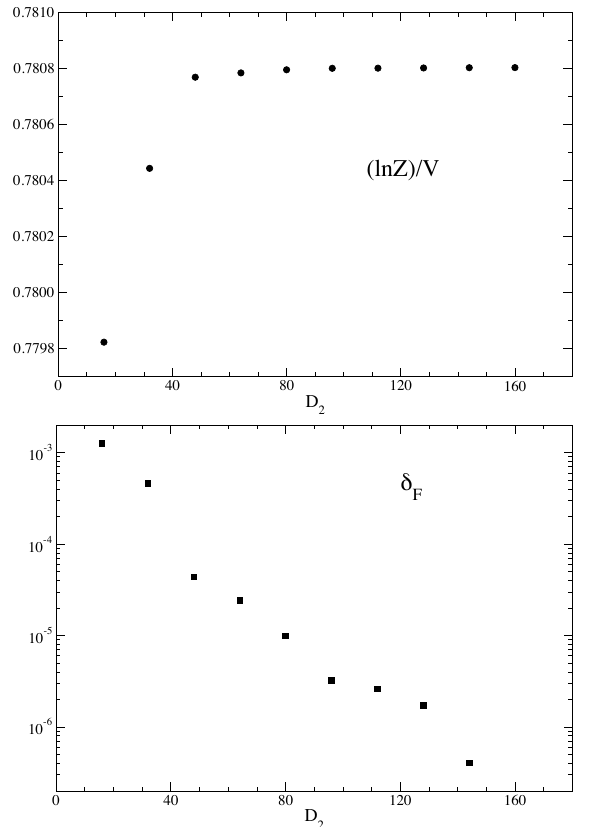
Figure 7 . D 2 dependence of (ln Z ) =V (top) and (cid:14) F (bottom) at (cid:12) = 0 : 71115 on the 4096 2 (cid:2) 3 lattice.